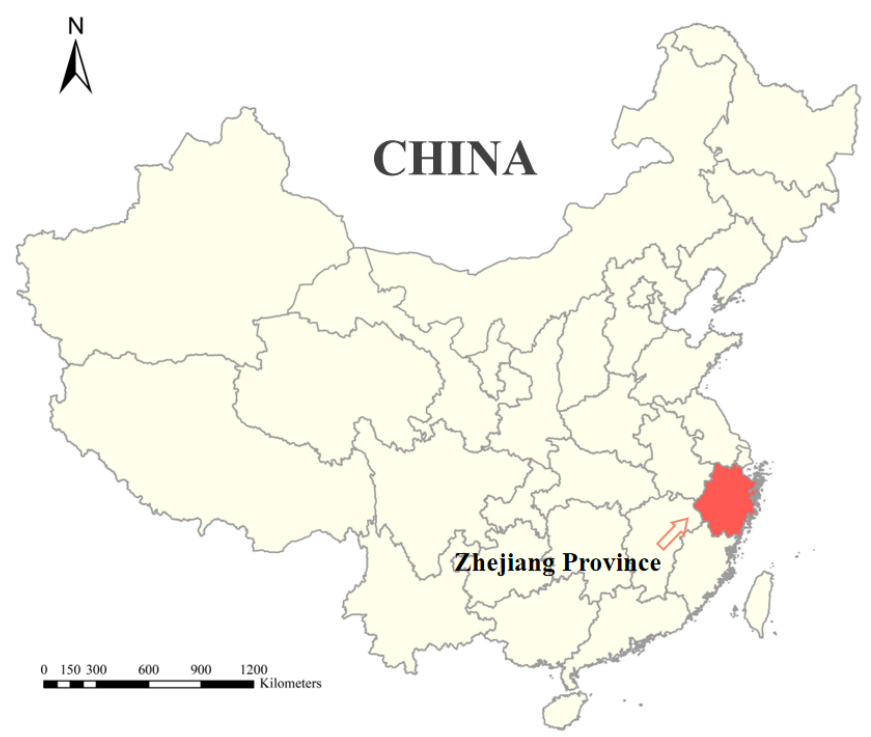
Figure 6. Location of Zhejiang Province,